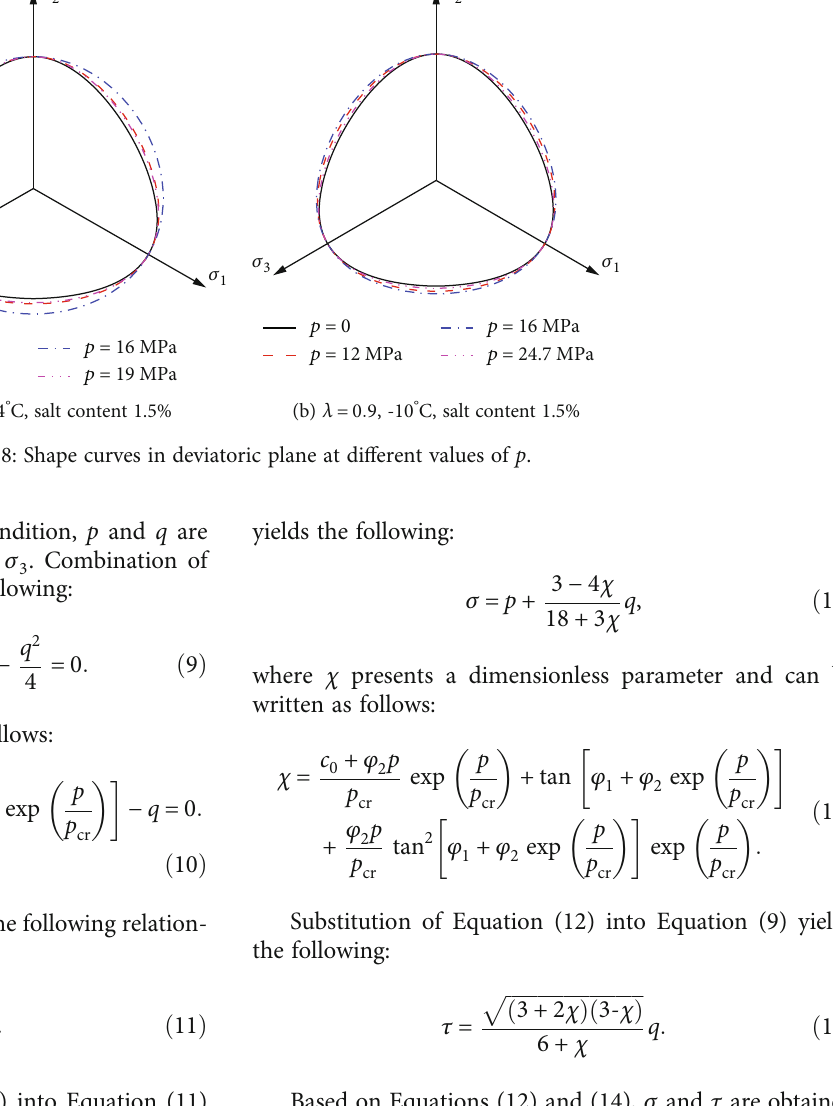
Figure 7: Shape function curves in deviatoric plane a ff ected by model parameters.